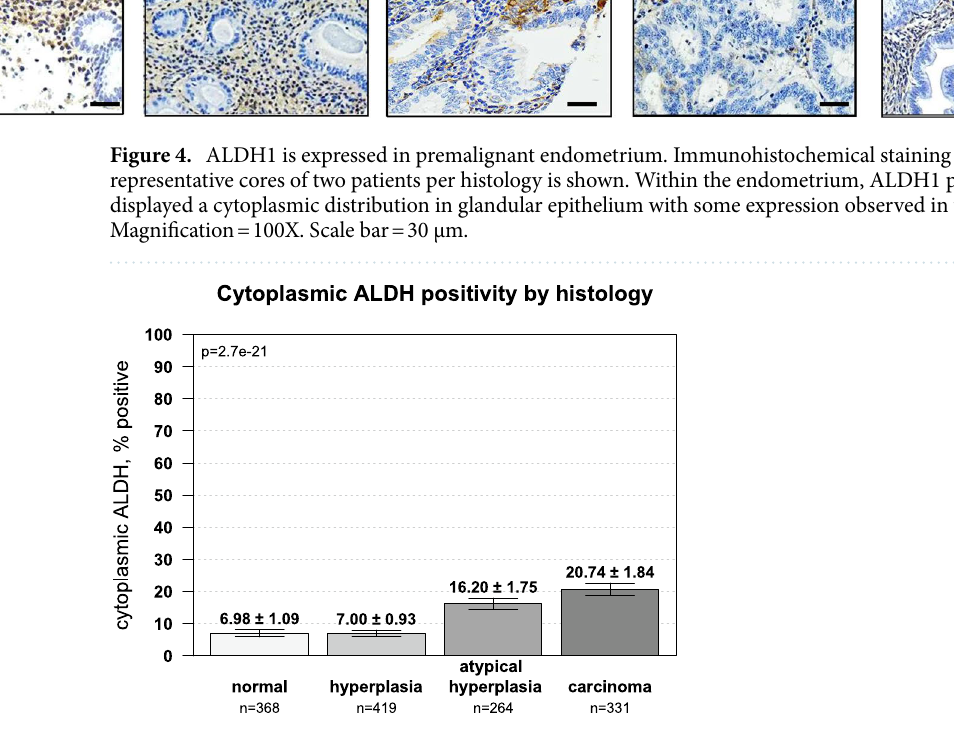
Figure 5. Epithelial ALDH1 expression increases occurs during malignant progression. The percentage of patients with epithelial ALDH1 expression showed a step-wise increase from endometrial hyperplasia to atypia to endometrial cancer. Spearman correlation for histologic progression was rho = 0.25 and p =